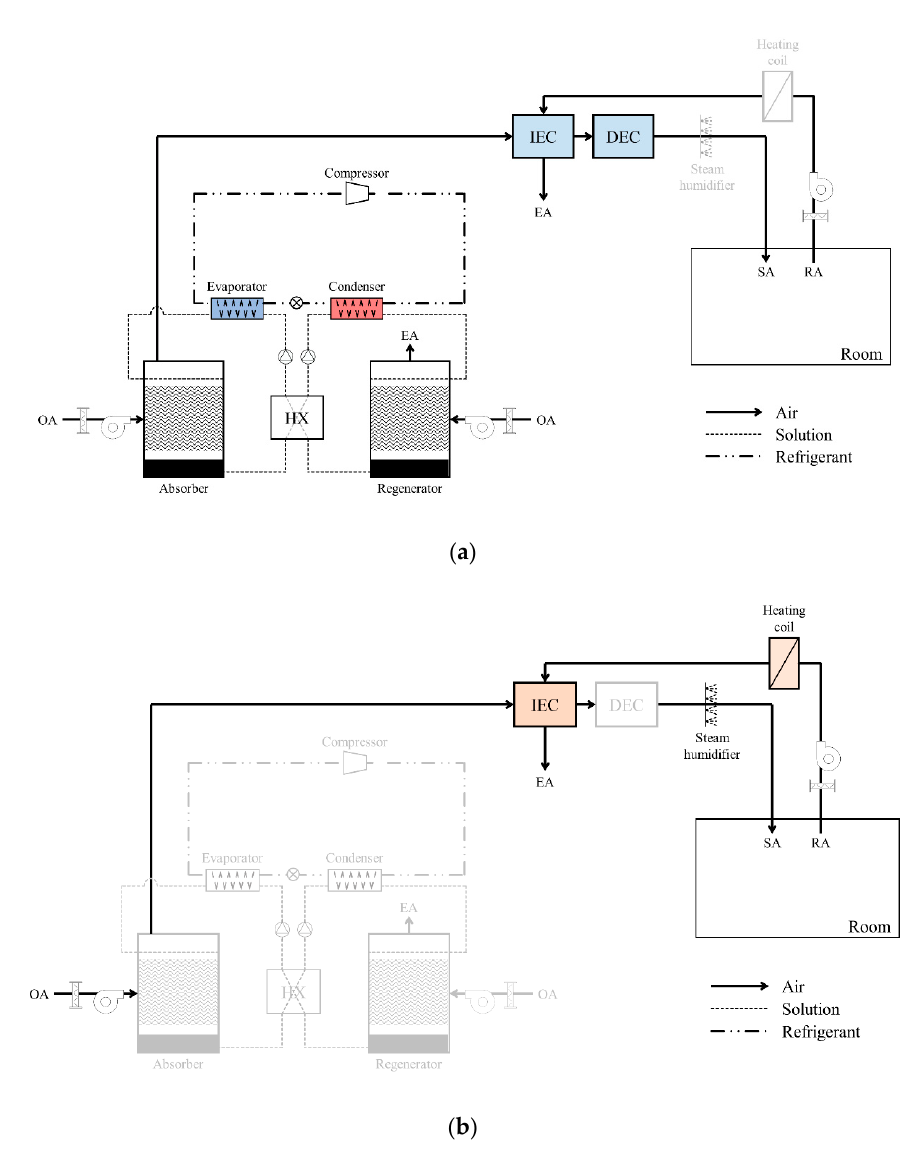
Figure 1. Schematics of existing liquid desiccant and indirect/direct evaporative cooling-assisted 100% outdoor air system (LD-IDECOAS) for ( a ) cooling and ( b ) heating seasons. DEC: direct evaporative cooler, EA: exhaust air, HX: heat exchanger, IEC: indirect evaporative cooler, OA: outdoor air, RA: return air, and SA: supply air.